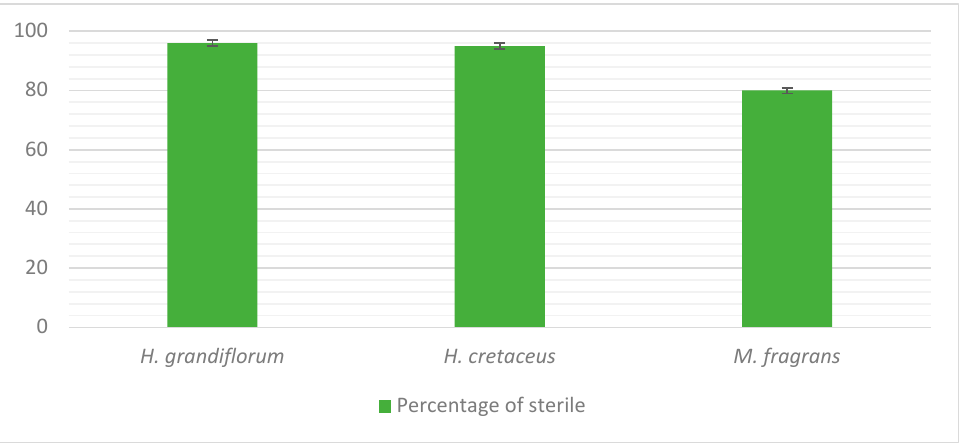
Figure 1. Results of application of methods of sterilization of seeds of objects of research.